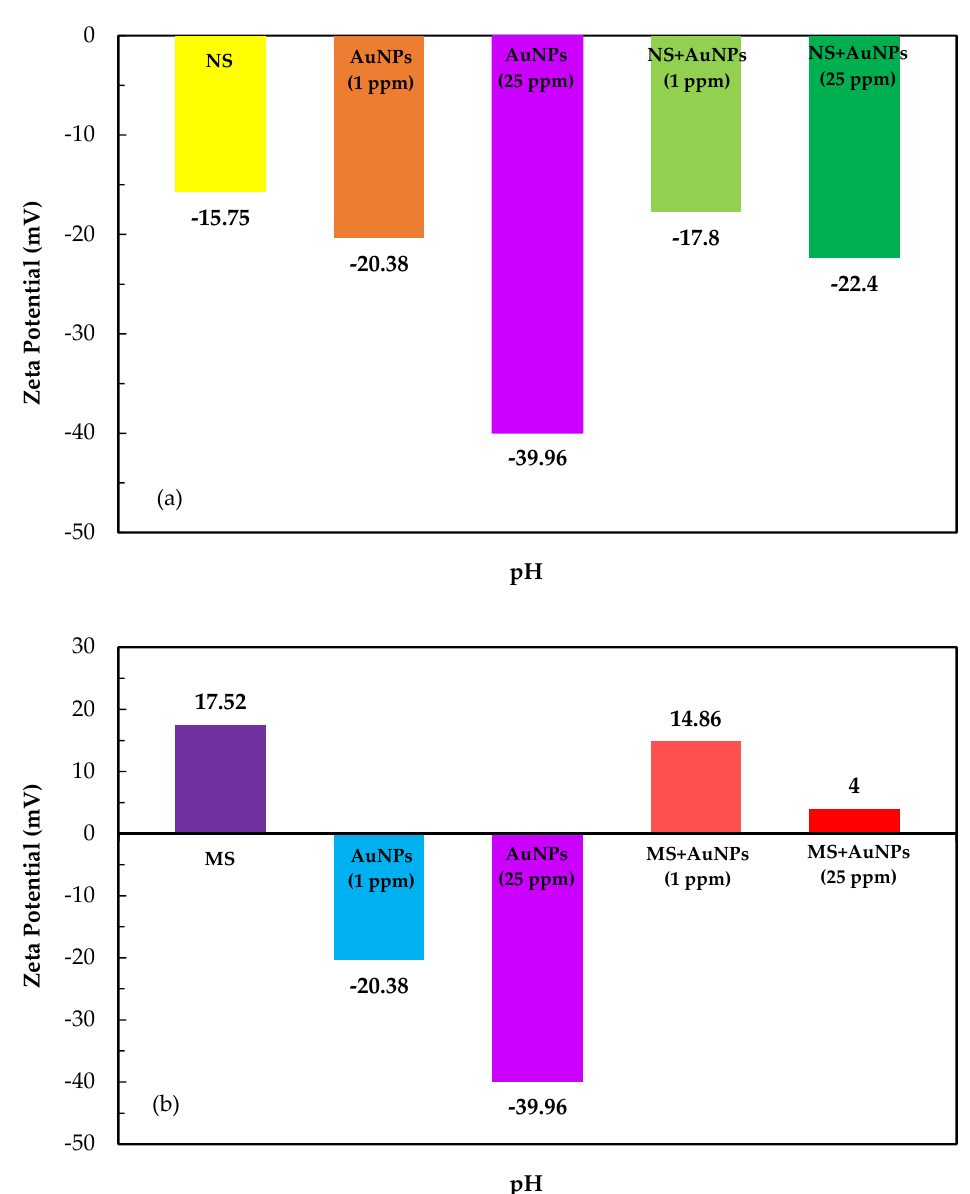
Figure 3. Histograms for zeta potentials of 1 and 25 ppm AuNPs / natural sepiolite (NS) ( a ) and 1 and 25 ppm AuNPs / modified sepiolite (MS) ( b ), respectively, as a function of pH.